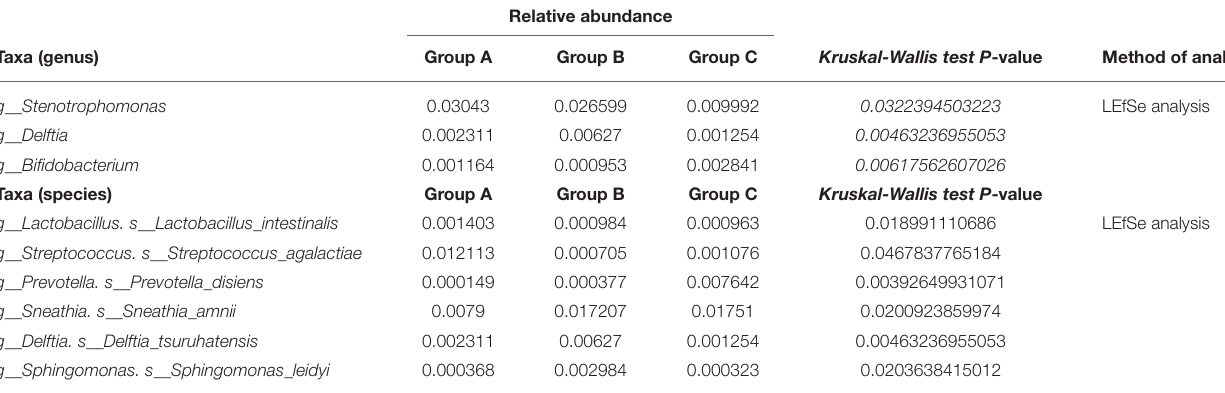
TABLE 3 | The statistically different genus and species within three groups by LEfSe analysis.